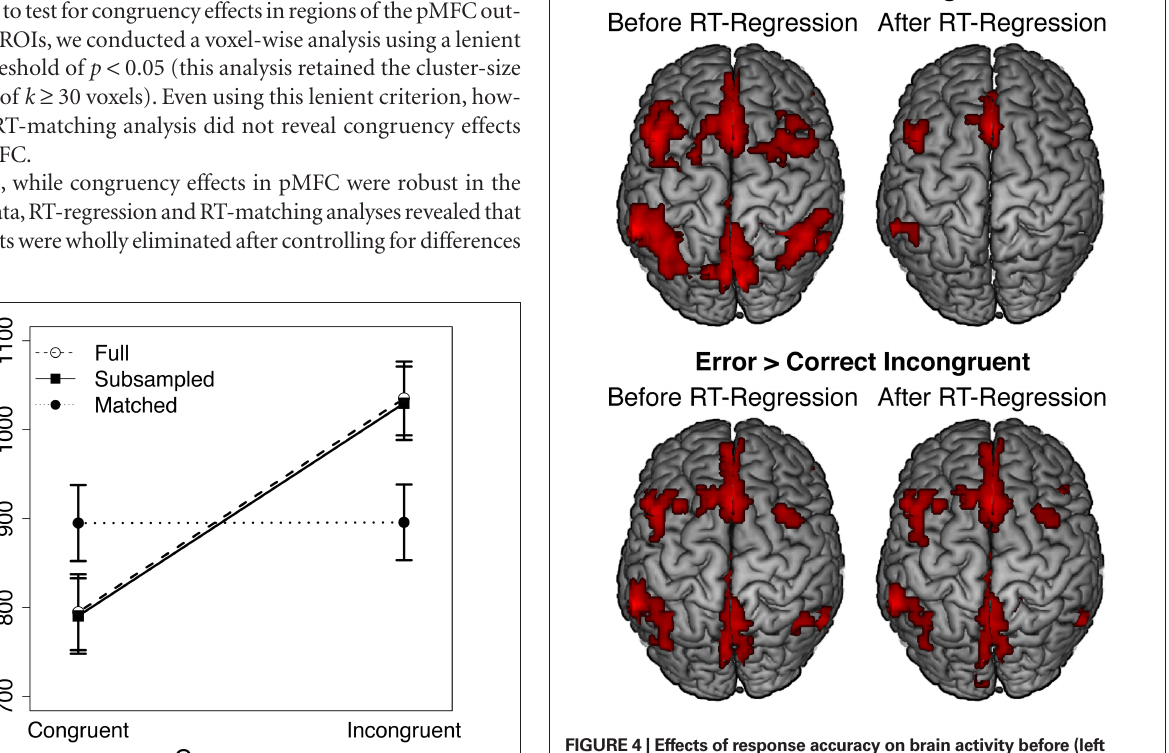
FIguRe 4 | effects of response accuracy on brain activity before (left panels) and after (right panels) statistically correcting for conditional differences in mean RT. For both contrasts, error-related pMFC activity remained robust after controlling for RT differences between conditions. All activations are overlaid on the Ch2bet template in MNI space. Activations are displayed using a height threshold of p ≤ 0.005 and an extent threshold of k ≥ 30